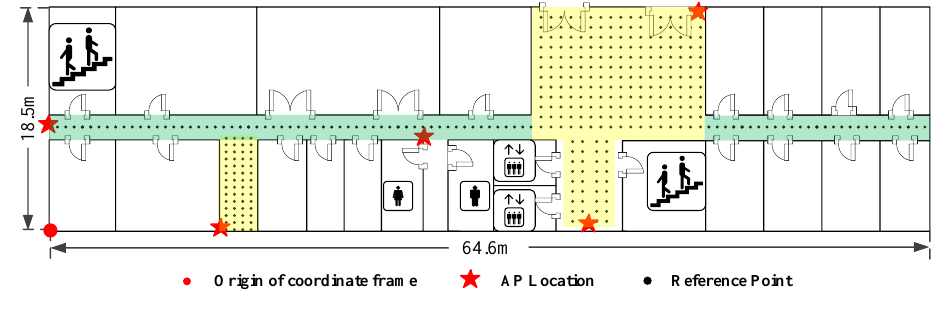
Figure 9. Environment layout.